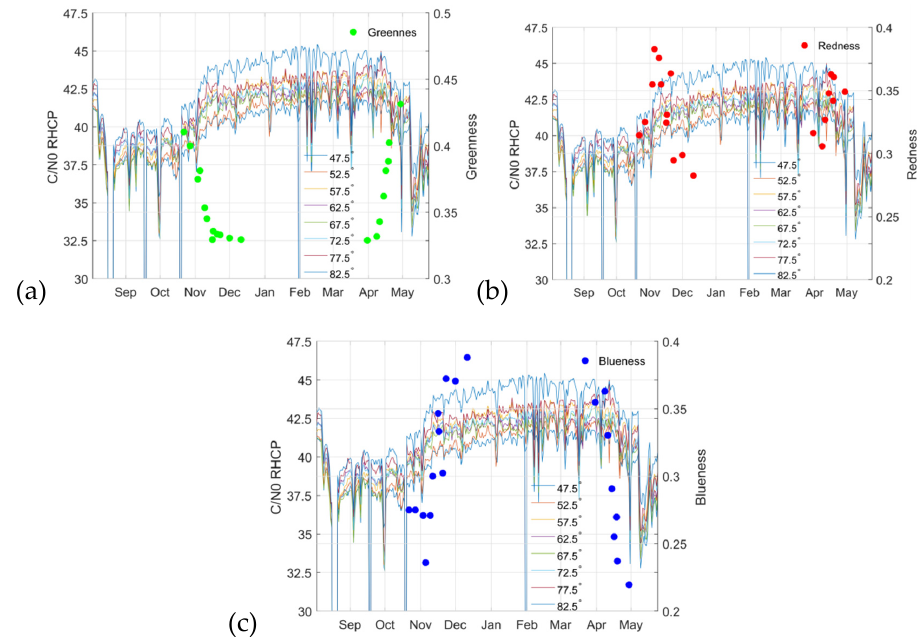
Figure 9. Evolution of ( a ) greenness; ( b ) redness; and ( c ) blueness, and C / N 0 curves as a function of time.